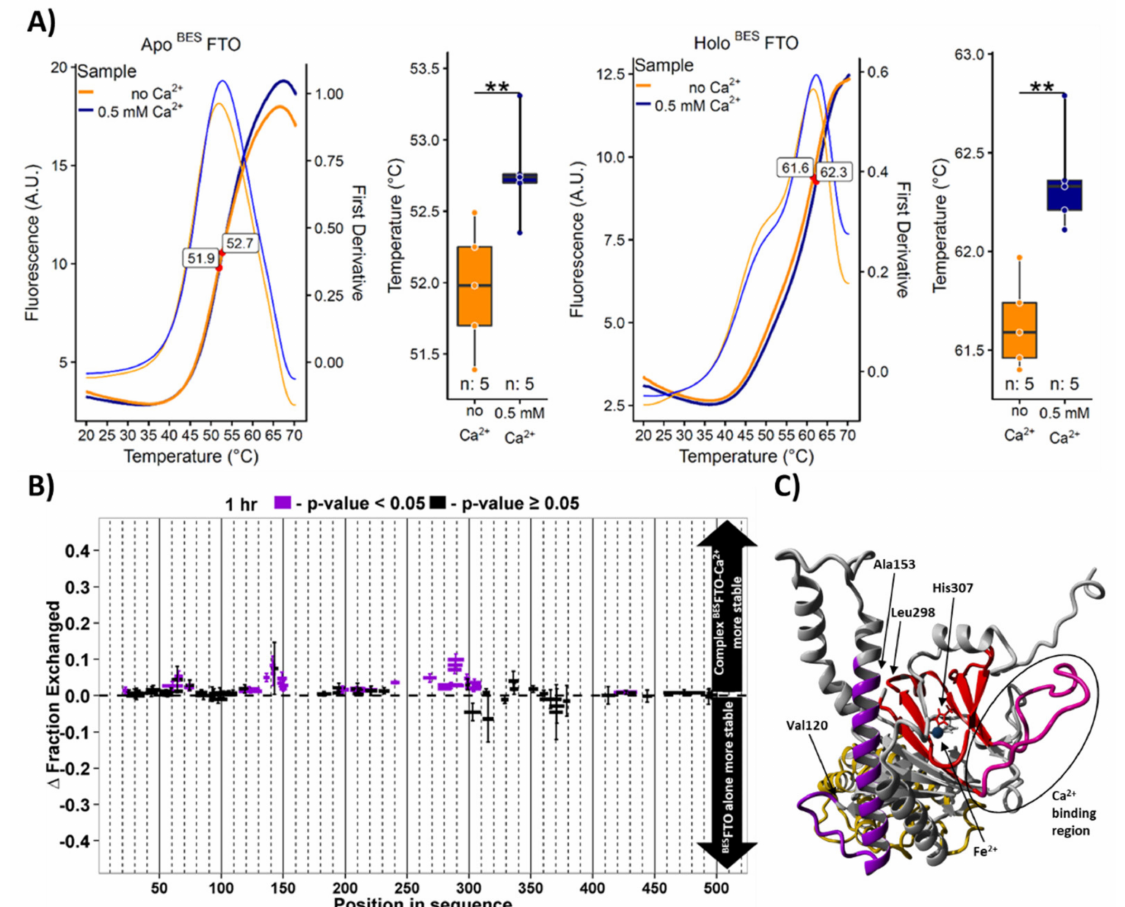
Figure 4. The effect of Ca 2+ on FTO parameters. ( A ) DSF analysis of the Ca 2+ effect on the thermal stability of BES FTO in the absence (apo) or presence of Mn 2+ and 2-OG (holo). Left, ratio of emissions (bold lines) and first derivative (thin lines) curves are shown as a function of temperature. All four protein samples display one distinct unfolding transition (red dots). Data gathered on the right are shown as boxplots. Box represents the interquartile range. Whiskers show the highest and lowest data points. The horizontal line within a box represents the median of the data. n—number of samples. A. U.—arbitrary units. ** p < 0.05. ( B ) HDX analysis of the Ca 2+ effect on the solvent accessibility of BES FTO after 1-h incubation with deuterium water. Differences between the exchange levels of individual peptides (each rectangle with whiskers represent one peptide) in samples with and without calcium are shown. Statistically significant differences ( p < 0.05) in peptide accessibility are marked in purple. Two regions of BES FTO are more stable in Ca 2+ presence, comprising residues 120–155 and 240–310. Each experimental setup was repeated four times. ( C ) Location of Ca 2+ -stabilized regions in the FTO molecule colored according to HDX data. Regions with significant exchange are marked in red and purple; the Ca 2+ binding part of the first region is marked in pink. The two protein regions stabilized by Ca 2+ lie close to each other in the structure. The FTO protein structure was modelled based on the PDB4IE5